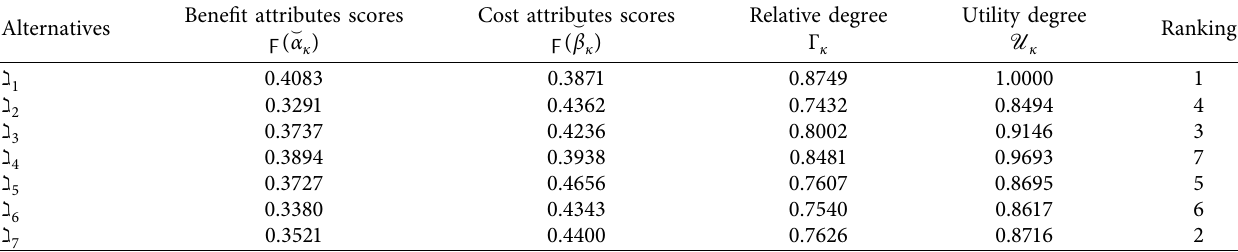
Table 7: Assessing outcomes of alternatives and ranking order by utilizing the 2TLC q -ROF-COPRAS.